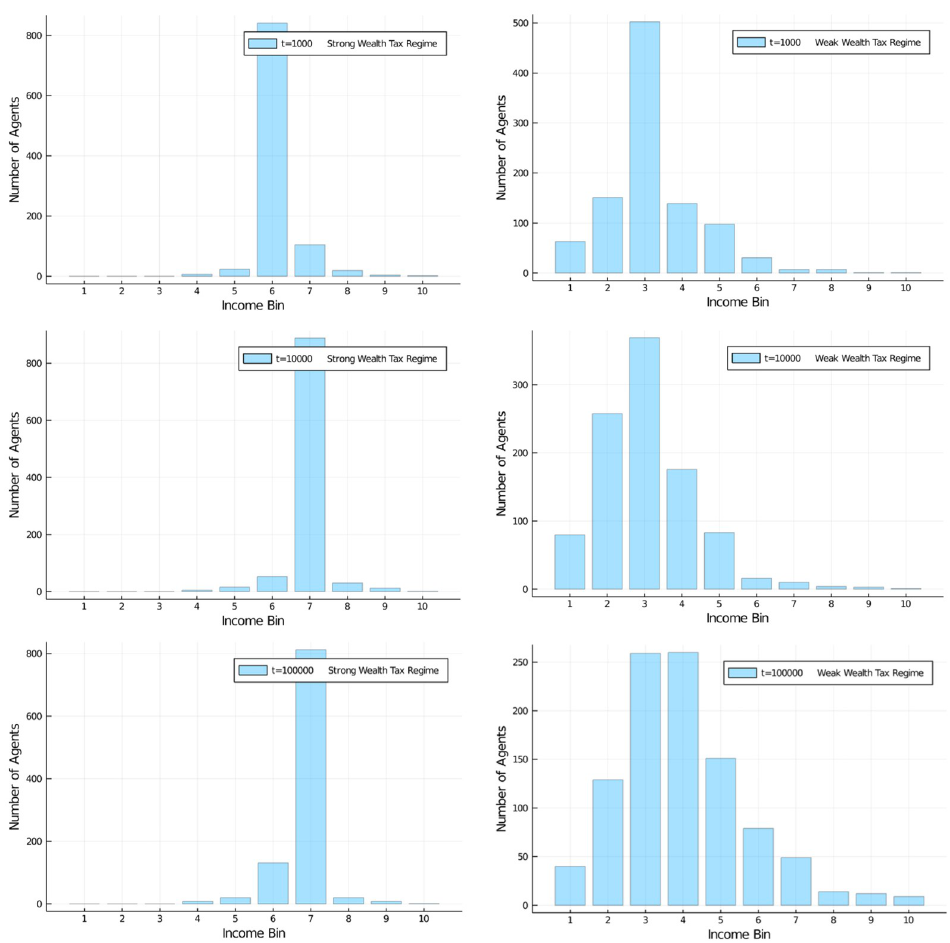
Fig 12. Comparison of wealth tax regimes. Wealth distribution in population of 1,000 agents (10 bins, a.u.). Flat wealth tax regime, with high (60%) and low (5%) flat tax. Comparison of high (left) and low (right) for redistribution policy at t = 1, 000;10, 000; and 100, 000. Initial distribution was equal among all 1,000 agents. High wealth tax increases wealth of middle class, low wealth tax reduced it in favour of a few high net-worth individuals.